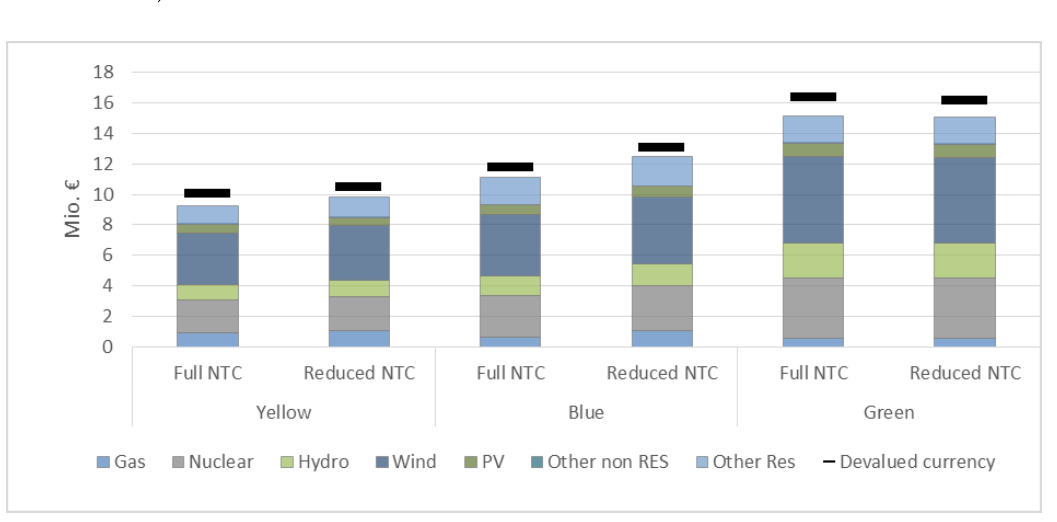
Figure 6. Interrelation of producer surplus and exchange rate volatility. Source: Own calculation.